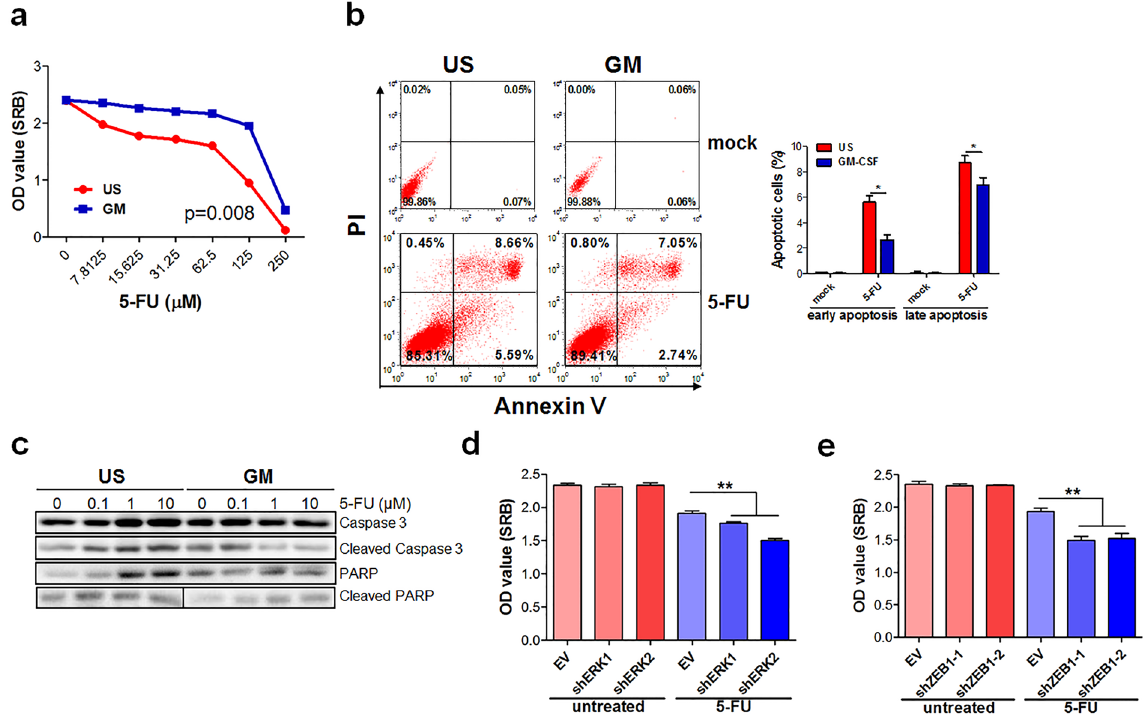
Figure 4. GM-CSF-exposed colon cancer cells exhibit chemoresistance. ( a , b ) SW480 cell line was stimulated with GM-CSF (25 ng/ml) for three weeks and then treated with fluorouracil (5-FU) at the titrated concentrations for three days. Cell vitality was detected by SRB assays ( a ) and flow cytometry ( b ). ( c ) SW480 cell line was exposed to GM-CSF as described above and treated with 5-FU at different doses indicated for 24 hours. Total and cleavaged caspase 3 and PARP proteins were examined by immunoblotting. Cropped blots were shown. ( d , e ) SW480 cell line with knockdown of ERK1, 2 ( d ) or ZEB1 ( e ) was stimulated with GM-CSF as described above and treated with 5-FU (25 μ M) for three days. Cell vitality was detected by SRB assays. The data were pooled from three independent experiments. One-way ANOVA methods were used to determine statistical significance for cell viability test. ** P < 0.01; *** P < 0.001 vs untreated or EV